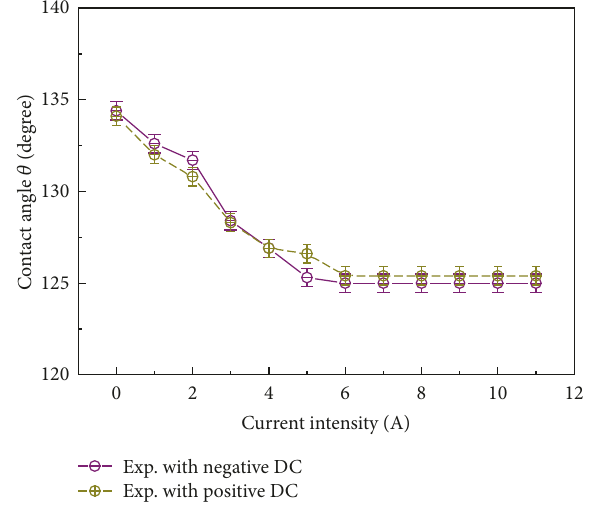
Figure 4: Contact angle versus current intensity and